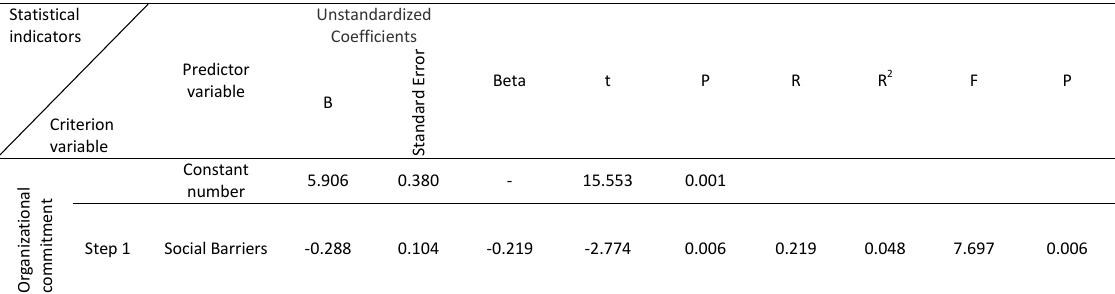
Table 2: The ability of glass ceiling dimensions for predicting organizational commitment Statistical indicators